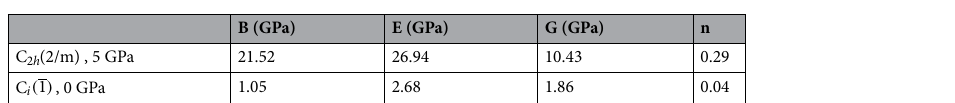
Table 1. Mechanical constants (Bulk, Young and Shear moduli and Poisson ratio) of the N 6 –N 2 polynitrogen at 5 and 0